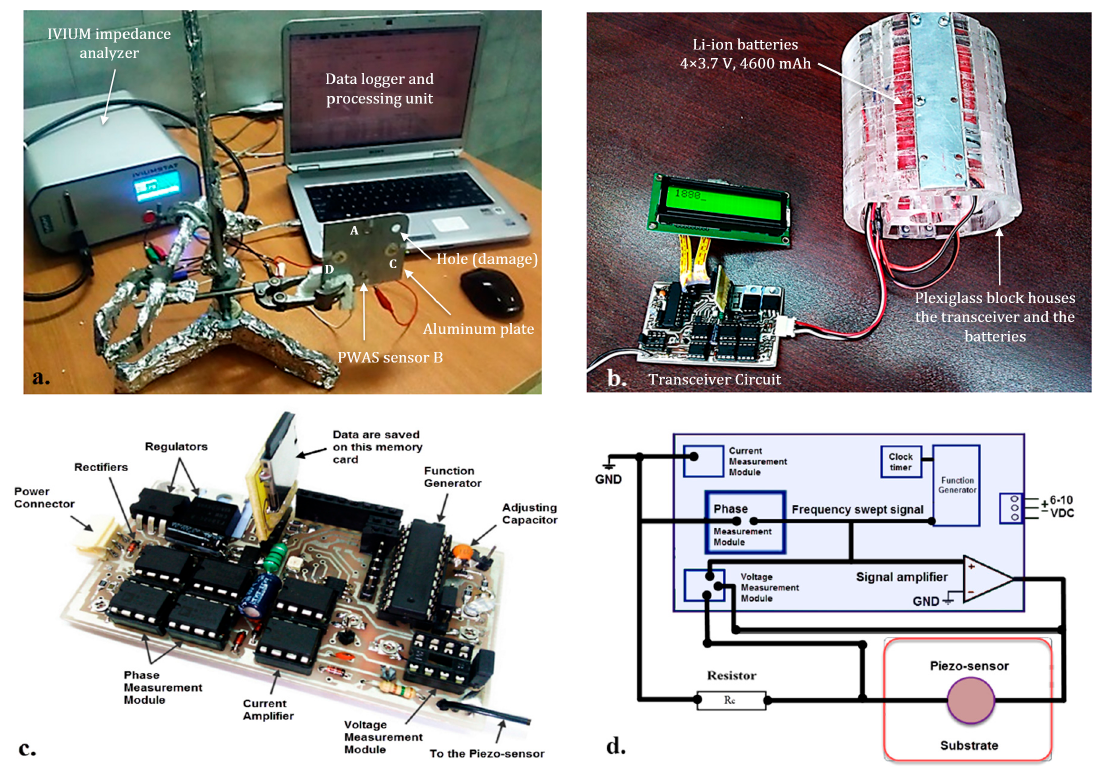
Figure 1. Hardware setup for the electromechanical impedance (EMI) frequency response measurement of bonded piezoelectric wafer active sensors (PWAS) sensors to an aluminum plate (100 × 100 mm), using ( a ) IVIUM analyzer and ( b ) transceiver circuit. ( c ) Portable EMI-based transceiver circuit and ( d ) architecture of transceiver components.